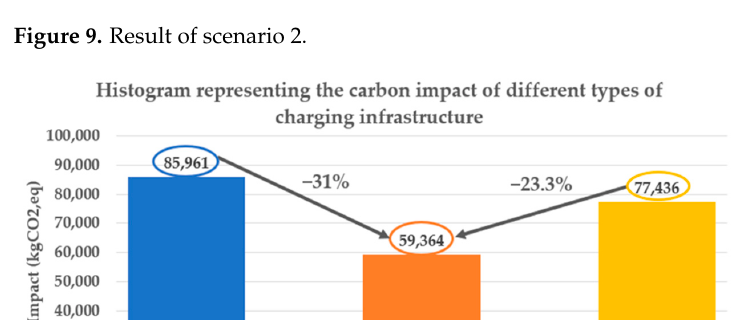
Figure 9. Result of scenario 2.